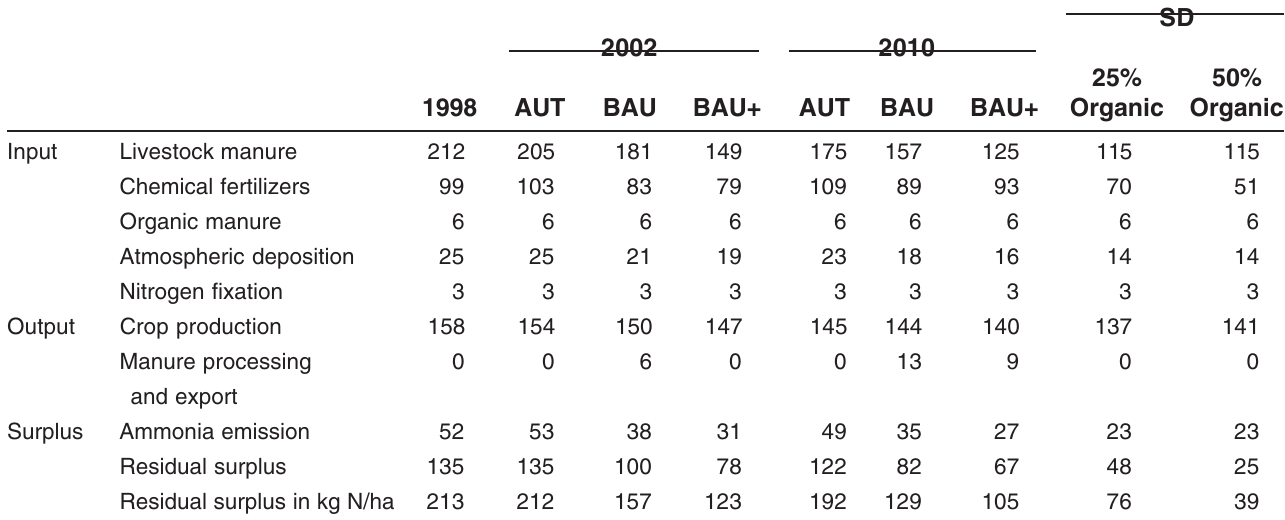
Soil Surface Balance for Nitrogen of the Flemish Agriculture in 1998 and for Four Scenarios (in million